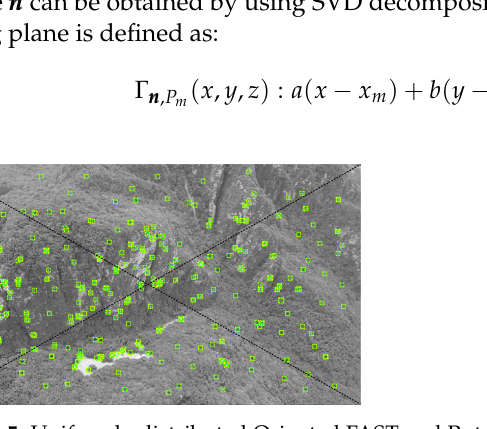
Figure 5. Uniformly distributed Oriented FAST and Rotated BRIEF (ORB) feature points are divided into four